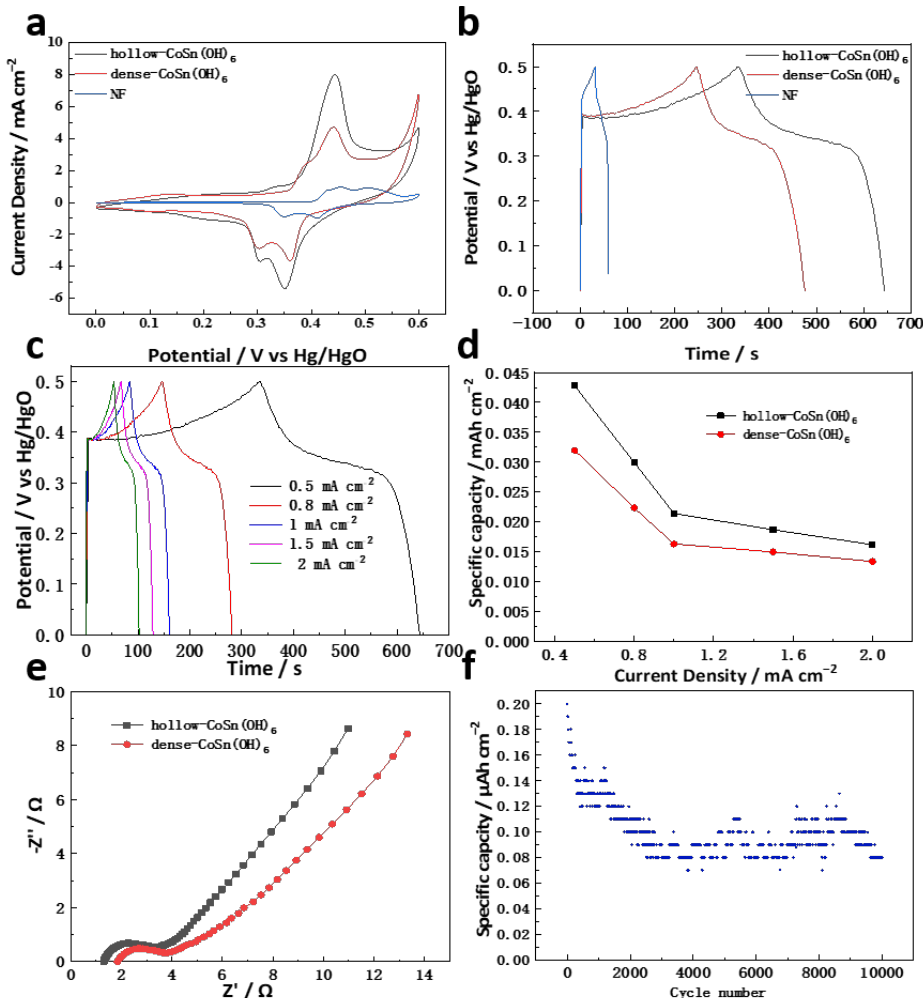
Figure 5. ( a ) CV curves at scan rate of 5 mV s − 1 and ( b ) GCD curves at current density of 0.5 mA cm − 2 of dense and hollow CoSn(OH) 6 nanocubes. ( c ) GCD curves of hollow CoSn(OH) 6 nanocubes and ( d ) corresponding variation in area-specific capacity at different current densities of dense and hollow CoSn(OH) 6 nanocubes. ( e ) Electrochemical impedance spectroscopy of dense and hollow CoSn(OH) 6 nanocubes. ( f ) Cycle stability of hollow CoSn(OH) 6 nanocubes.